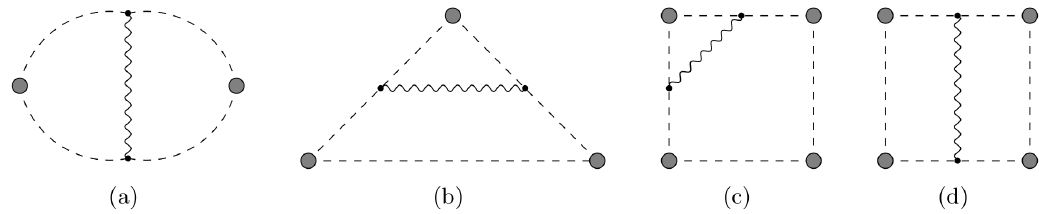
Figure 1 . Topologies of one-loop diagrams contributing to the correlators.